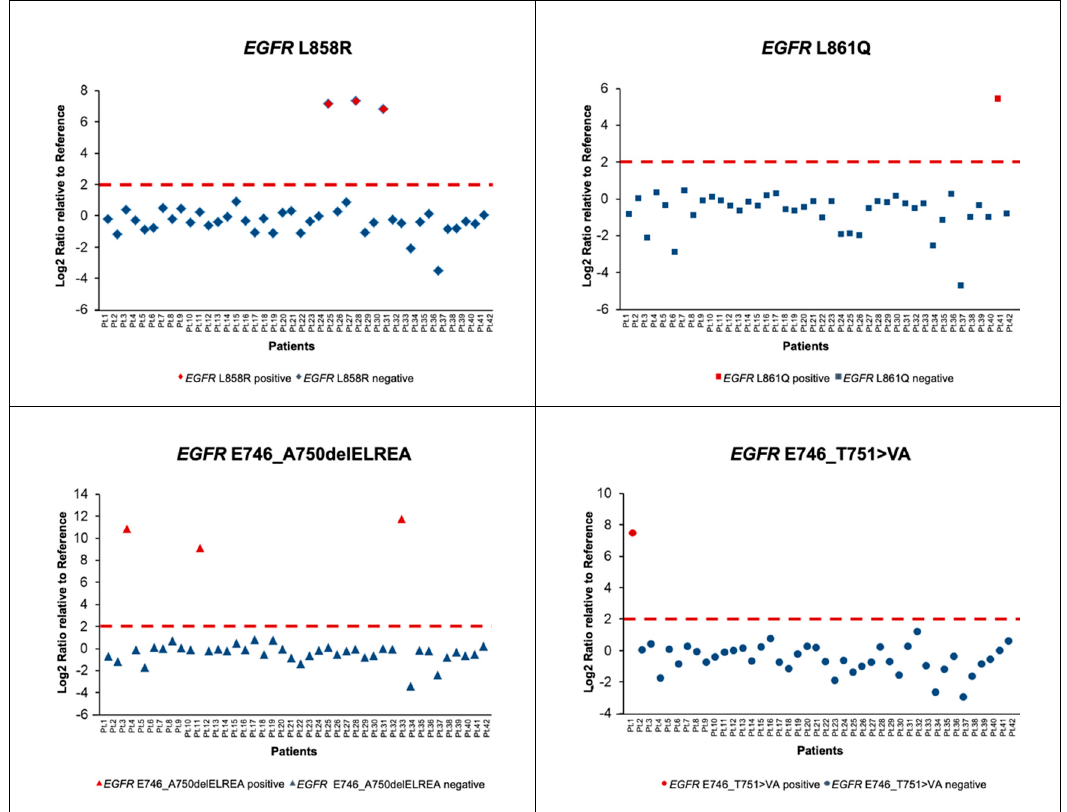
Figure 4. Normalized EGFR values for the 42 patients analyzed with nCounter platform. Pt: patient.